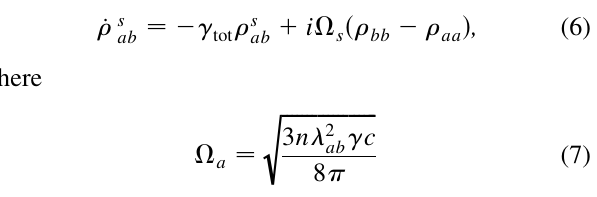
p ffiffiffiffiffiffiffiffi N ph ,